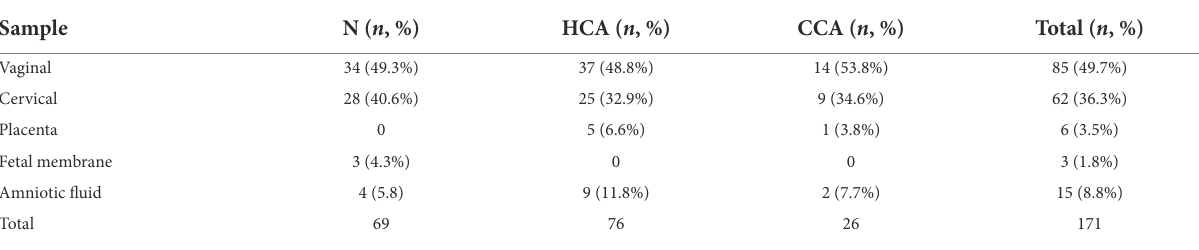
TABLE 3 Distribution of eligible and qualified